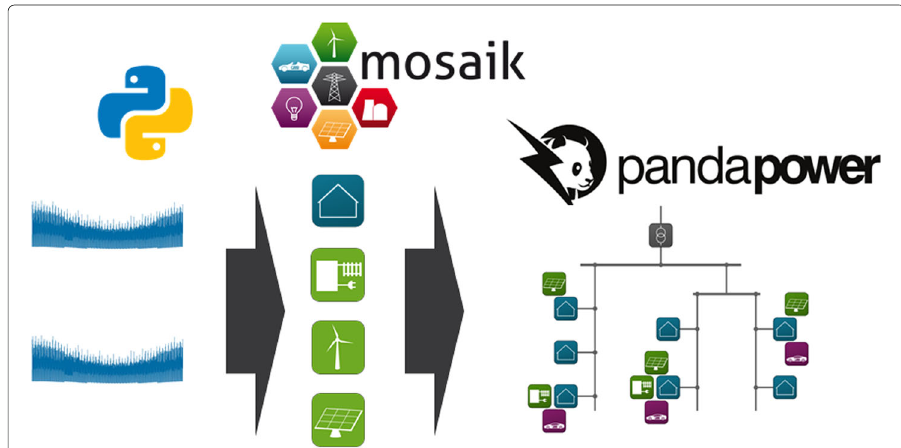
Fig. 2 The general setup for the research in this work. Different components are involved, not all of which have been considered in this paper. However, these are still important for future